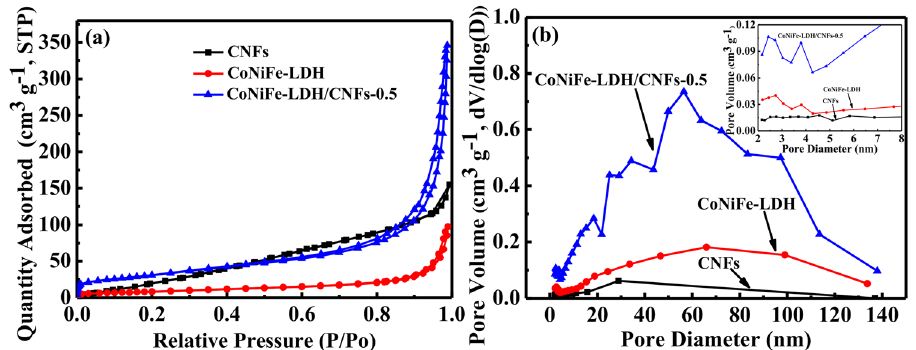
Figure 5. ( a ) Nitrogen adsorption/desorption isotherms of original CNFs, pure CoNiFe-LDH and CoNiFe- LDH/CNFs-0.5 composite; ( b ) the pore size distribution of original CNFs, pure CoNiFe-LDH and CoNiFe- LDH/CNFs-0.5 composite (the inset exhibits the corresponding magnified pore size